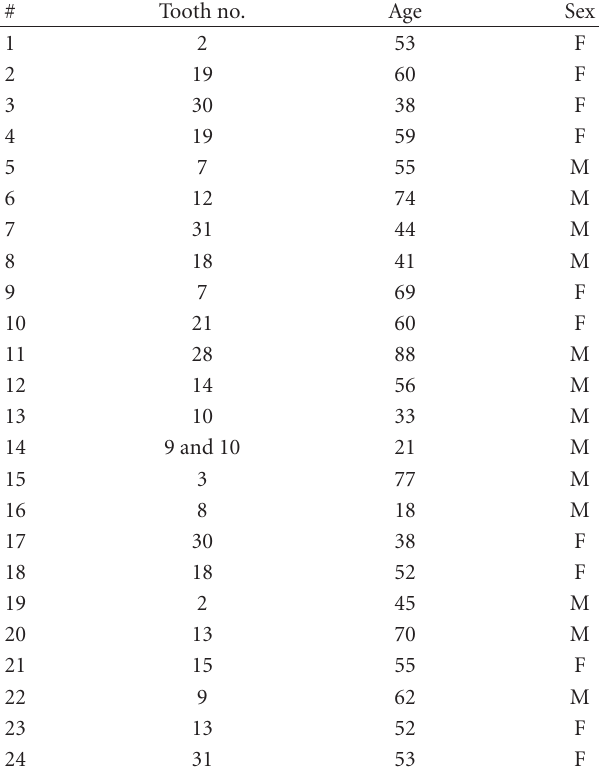
Table 1: Study demographics including tooth no., patient age, and